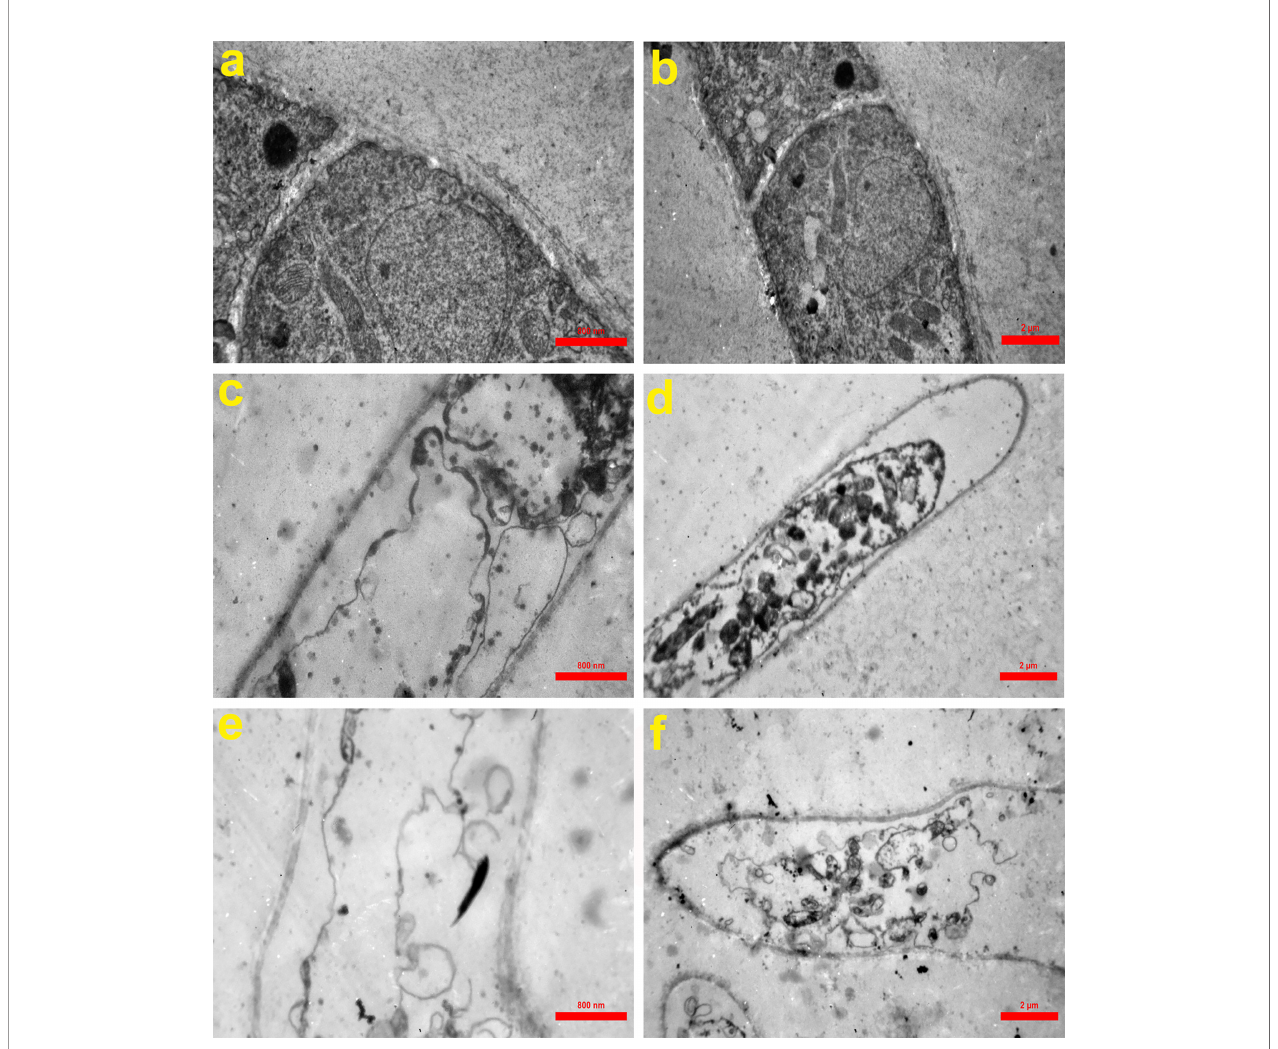
FIGURE 6 | Transmission electron microscopy of A. fumigatus -untreated hyphae (A, B) and hyphae exposed to Cc-AFP1 at the concentrations of 16 µg/ml (C, D) and 32 µg/ml (E, F) . Untreated hyphae of A. fumigatus had intact cell walls, integrated cell membranes, and normal organelles (A, B) . In contrast, in treated hyphae with Cc-AFP1, pathologic ultrastructure changes including attenuated irregular cell wall, loss of the structural integrity and shrinkage of the cell membrane, detachment of the cell membrane from the cell wall, cytoplasmic depletion, and membranous damage of cytoplasmic organelles especially mitochondria were evident (C – F)